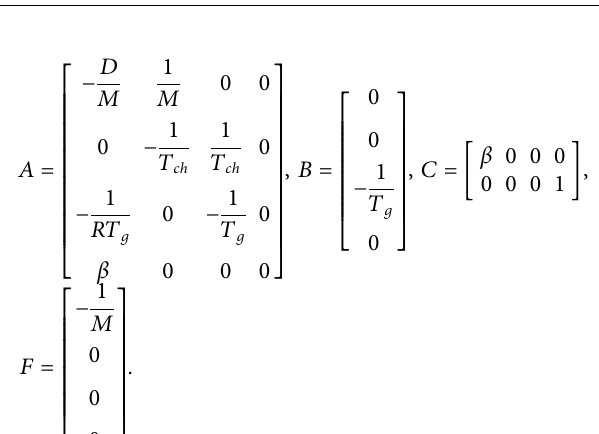
FIGURE 1 | The basic diagram of the simpli fi ed LFC of one-area power system.